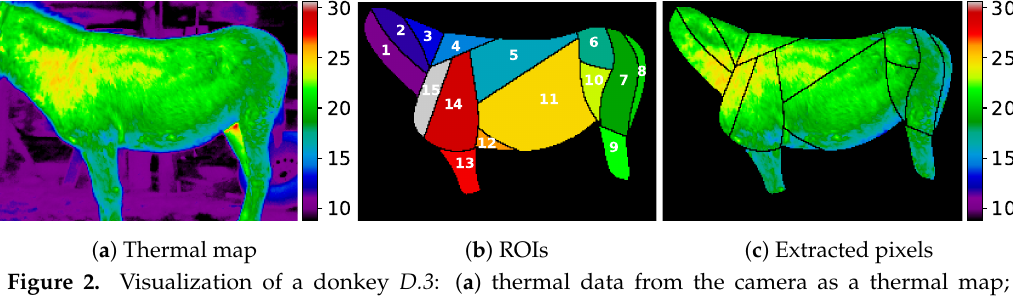
Figure 2. Visualization of a donkey D.3 : ( a ) thermal data from the camera as a thermal map; ( b ) annotated classes corresponding to selected ROIs (see Section 2.2.1); ( c ) extracted pixels used in the